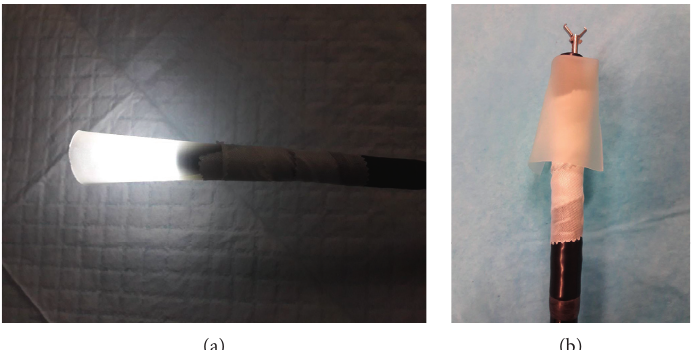
Figure 3: (a) Rubber folded in coned fashion forming a bell-shaped hood and secured with silk tape. (b) Hood-inverted back on itself before scope insertion.